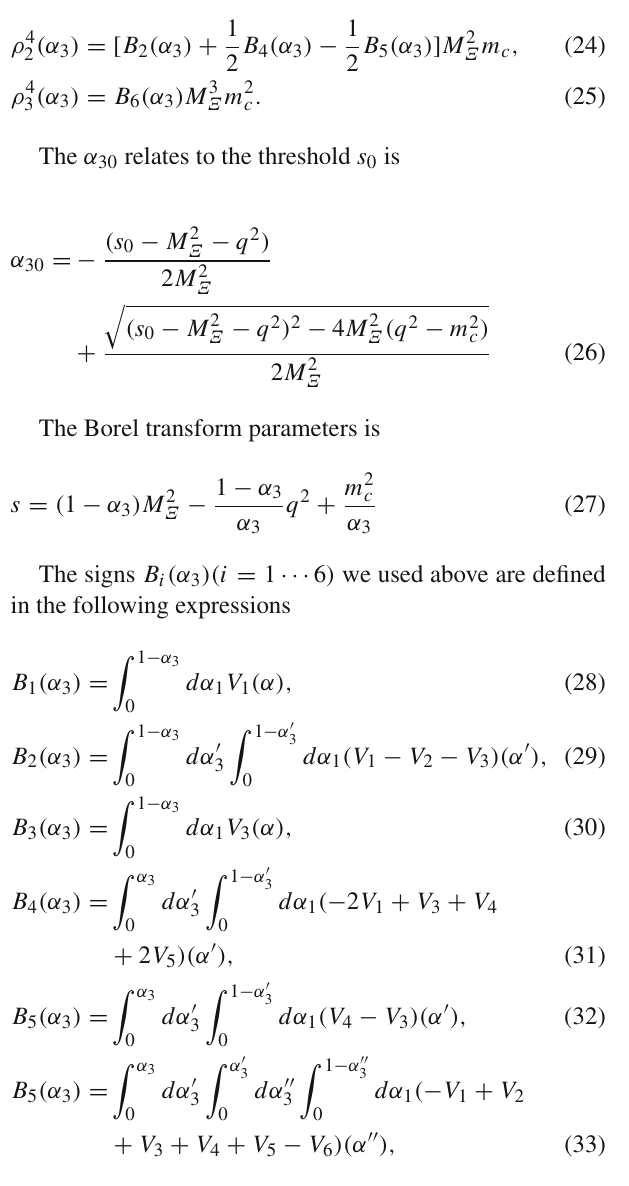
Fig. 1 The dependence of form factor f 1 on Borel Parameter at q 2 = 0 between 8GeV 2 < M 2 = 8 . 5GeV 2 of the momentum transfer square 0 < q 2 < 1GeV 2 M 2 B